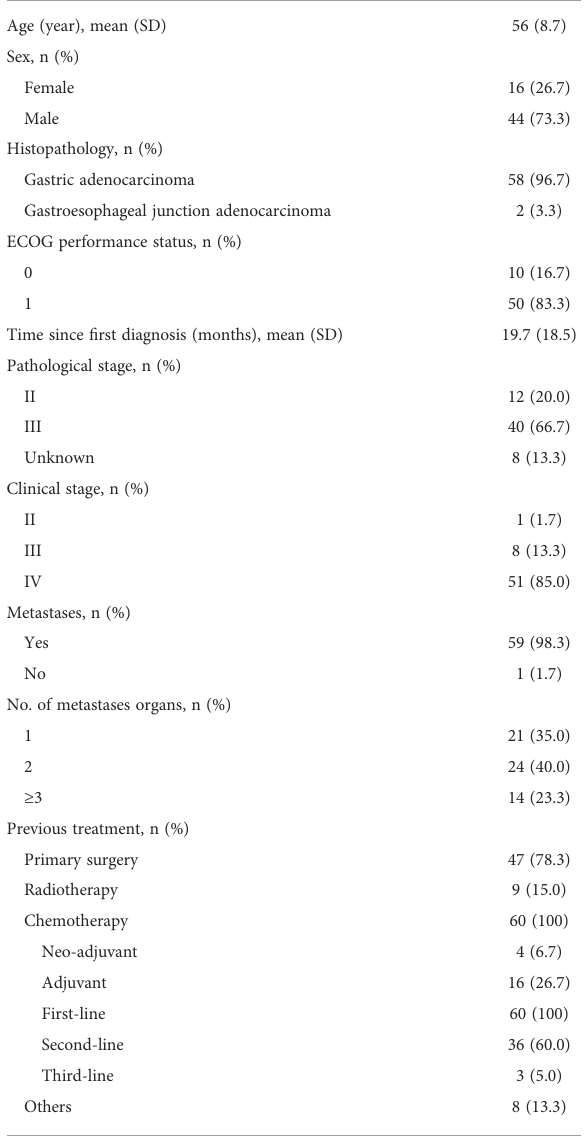
characteristics are summarized in Table 1. The percentage of patients with an ECOG performance status of 1 was 83.3% at baseline, 85.0% of patients were diagnosed with clinical stage IV disease, 98.3% had metastases, 78.3% received primary surgery, and 65.0% experienced at least two lines of chemotherapy. At data cutoff on December 10, 2018, 21 patients (35.0%)